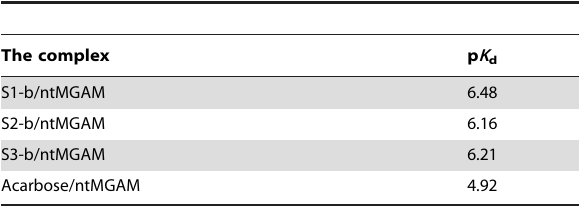
Table 2. Molecular docking study of different compounds and ntMGAM.